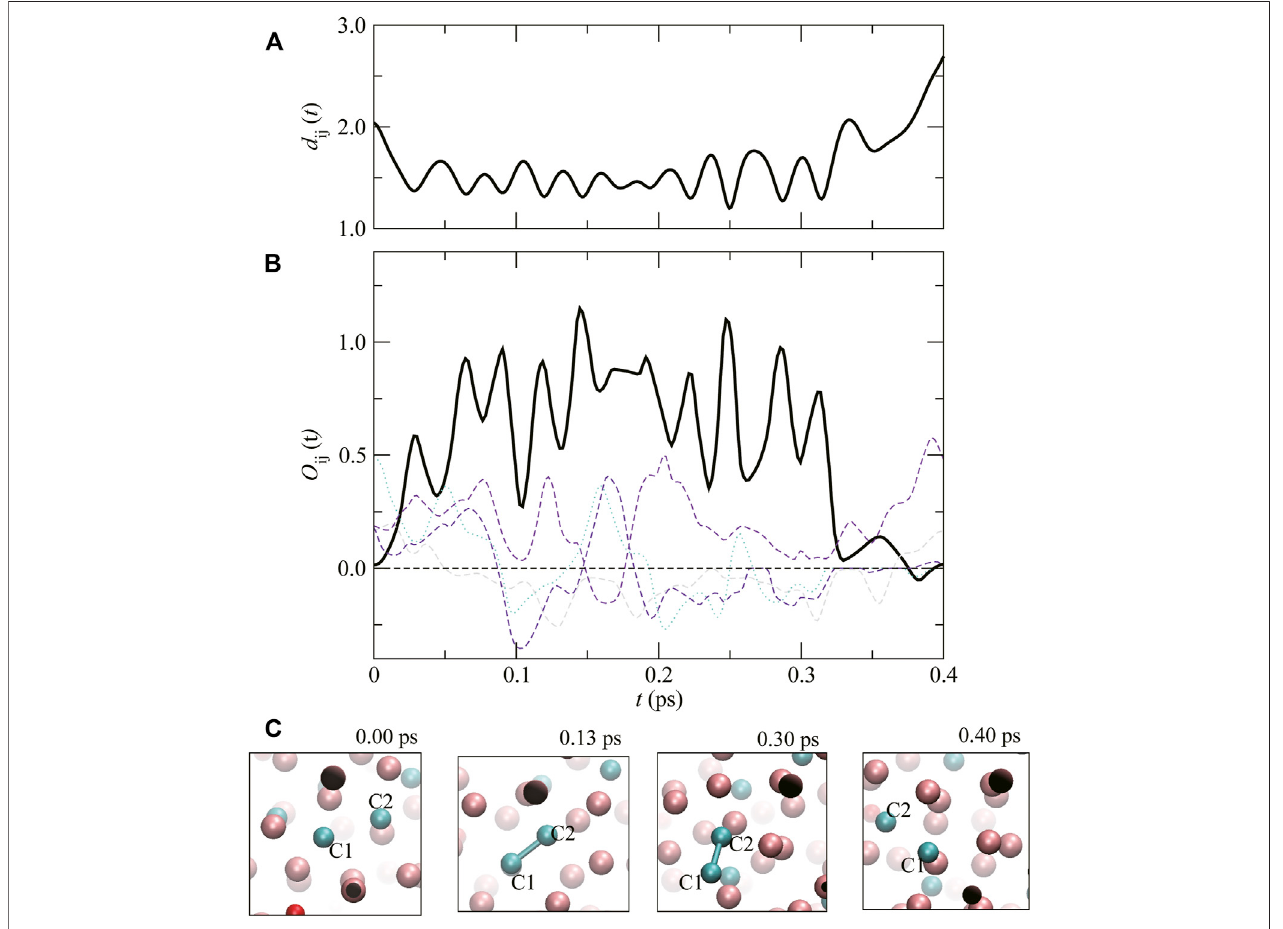
FIGURE4|(A) ThetimeevolutionofatomicdistancebetweenC1andC2, d C1 – C2 ( t ),and (B) theoverlap population, O C1 − C2 ( t ) (Thicksolidline).Dashedlinesshow O C1 − Fe ( t ) . (C) Atomic con fi gurations around C1 and C2 at t = 0.00, 0.13, 0.30 and 0.40 ps. The pink, green and red spheres correspond to Fe, C and O atoms, respectively. The dark spheres represent Fe atoms that are in the process of moving outside the frame, and towards the paper boundary.